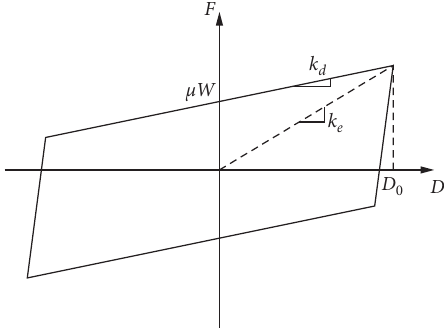
Figure 2: Bilinear hysteresis